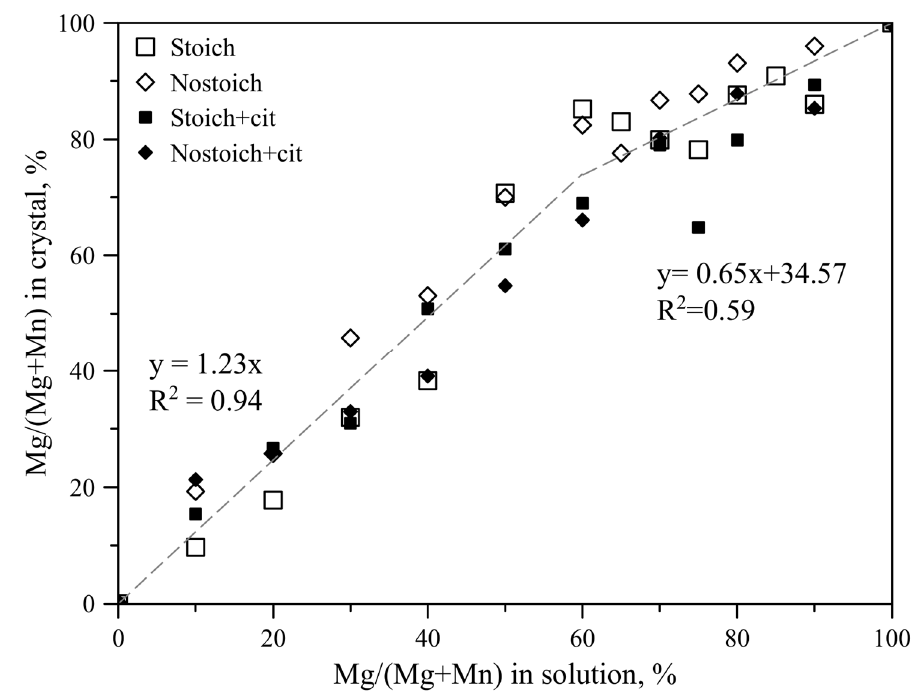
Figure 8. Dependence of Mg content in crystalline solid solutions (Mg, Mn)C 2 O 4 · 2H 2 O on its content in solution. Average values are given.